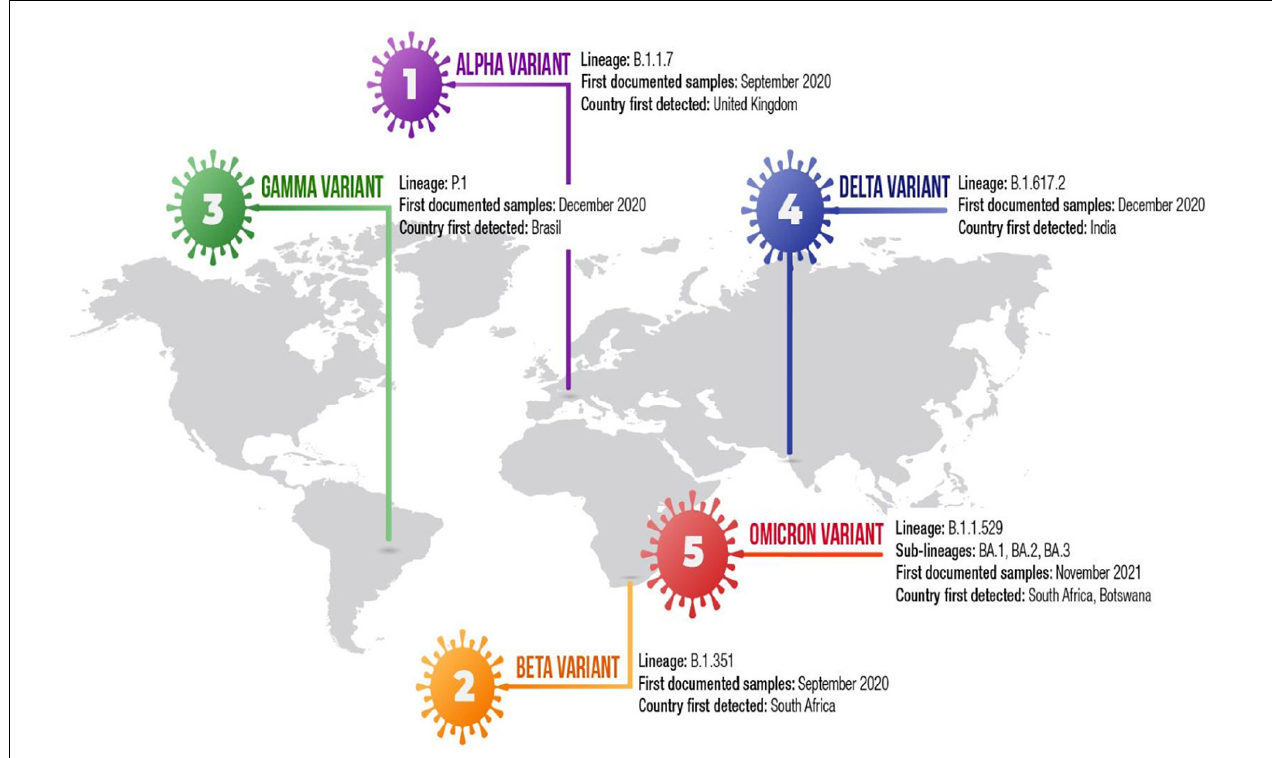
FIGURE 2 | Timeline of the SARS-CoV-2 variant of